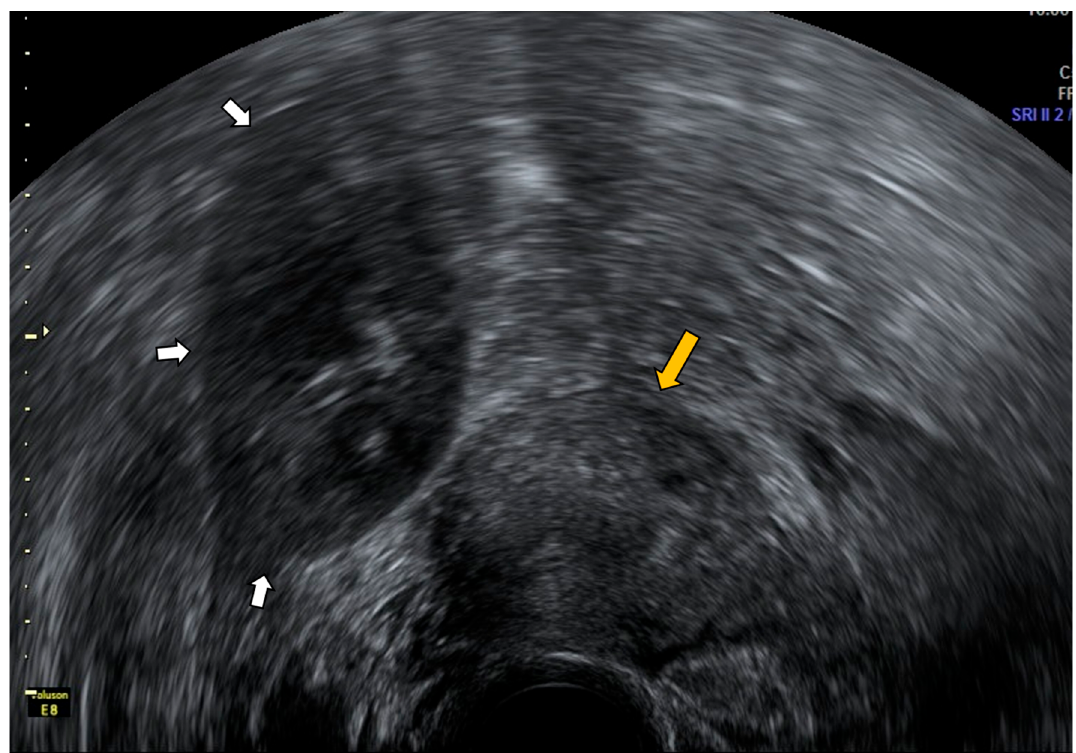
Figure 16. Transvaginal ultrasound shows a transversal view of the uterus (yellow arrow) and a solid mass in the right iliac fossa pointed with white arrows, presenting the ultrasonographic renal characteristics corresponding to an ectopic kidney.